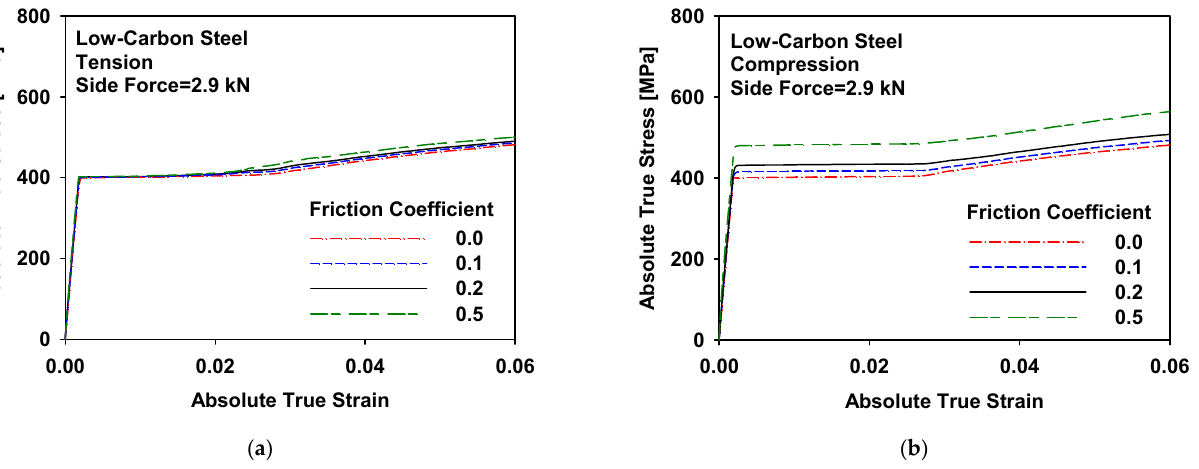
Figure 13. FE calculated stress – strain curves with various friction coefficients for ( a ) tensile and ( b ) compressive tests.